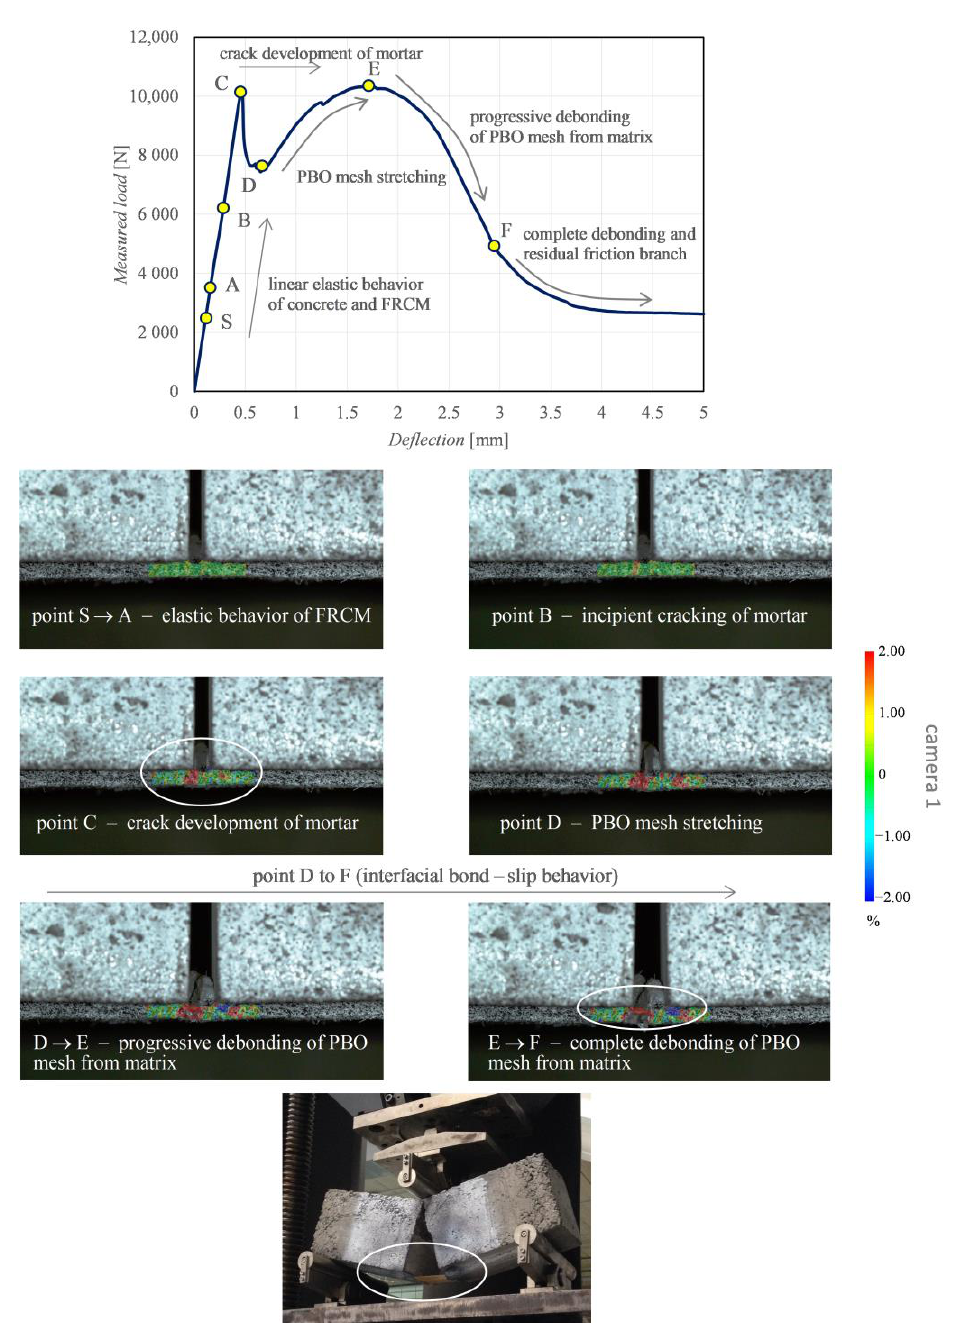
Figure 12. Representative beam: characteristic points in the load-deflection curve, and DIC-processed longitudinal strain maps from camera 1 examining the FRCM-concrete interface.